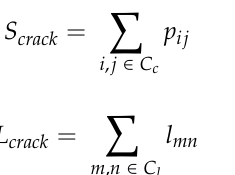
Figure 13. Examples of crack skeleton extraction and size calculation.